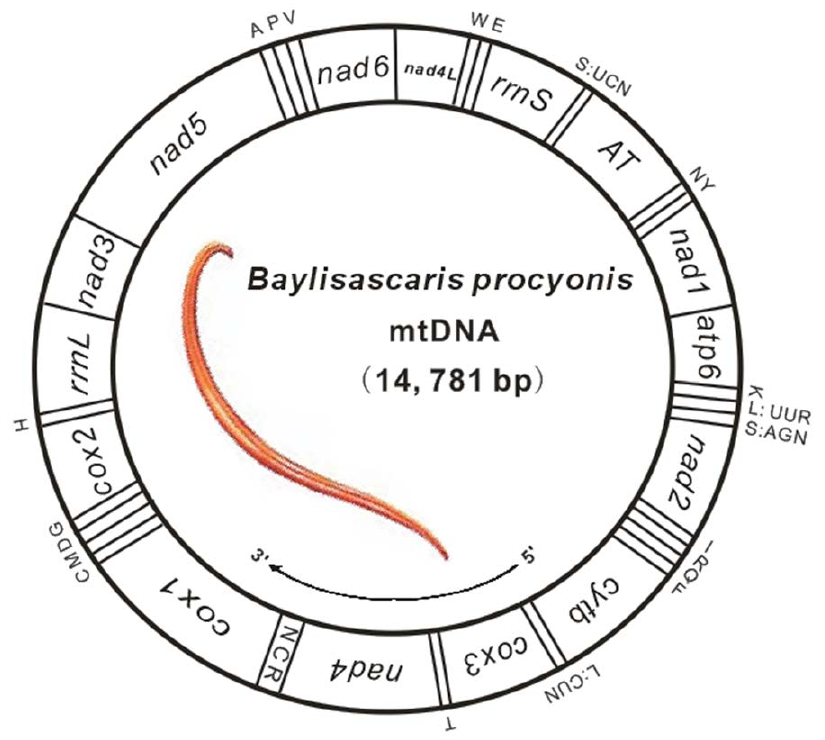
Figure 1. Graphical representation of B.procyonis mt genome. Gene abbreviations are as follows: atp6 , ATP synthase subunits 6; cox1-3 , cytochrome oxidase c subunits 1–3; cytb , cytochrome b; nad1-nad6 and nad4 L, NADH dehydrogenase subunits 1–6 and 4L; rrn L and rrn S, ribosomal RNAs. Transfer RNA genes are indicated by one letter symbol according to the IPUC-IUB single-letter amino acid codes. The two leucine and the two serine tRNA genes are differentiated by their respective anti-codons. AT denotes the AT-rich region. The direction of transcription is indicated by an arrow (5 9 to 3 9 ).